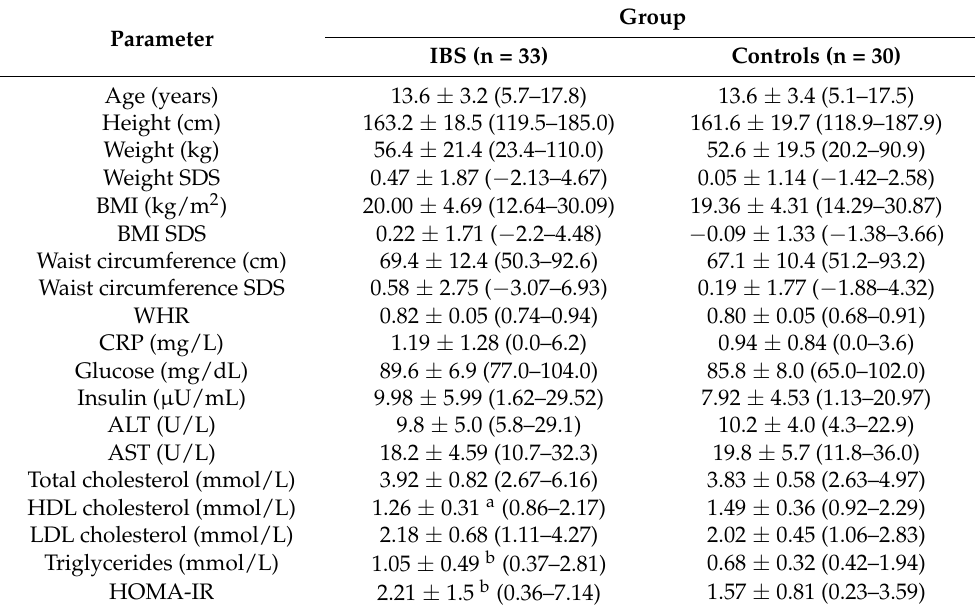
Table 1. Clinical characteristics of the irritable bowel syndrome (IBS) patients and control group (C). Data are presented as means, standard deviations, and